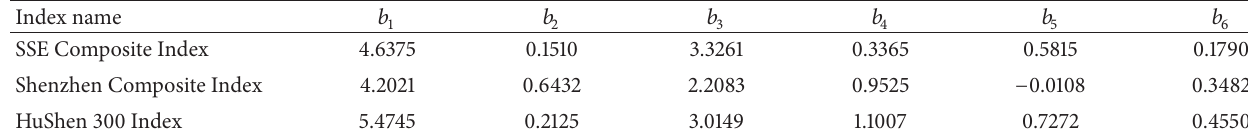
Table 2: Optimal parameters obtained by the BSO